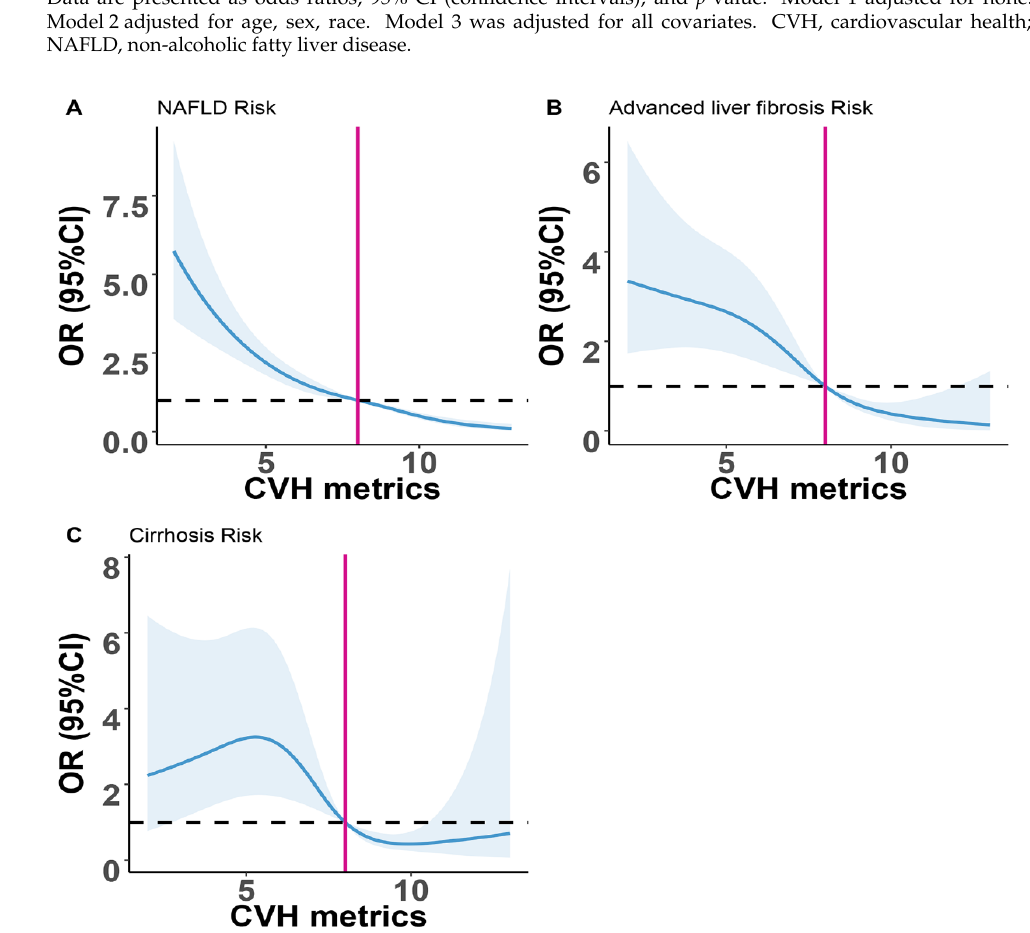
Figure 2. Restricted cubic spline plots of the association of CVH metrics with ( A ) NAFLD, ( B ) ad- vanced liver fibrosis, and ( C ) cirrhosis. The results were adjusted for all covariates. CVH, cardiovas- cular health; NAFLD, non-alcoholic fatty liver disease. NAFLD, non-alcoholic fatty liver